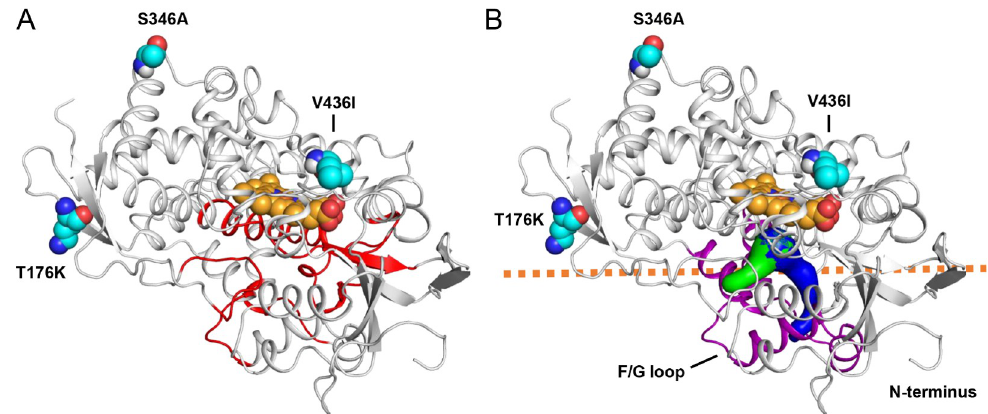
Fig 6. CYP6ER1vA model showing sequence variants (cyan) and heme (orange). (A) SRS1-6 regions are coloured red. (B) Access tunnels leading to the active site are shown in surface format. The predicted membrane-solution interface is depicted with orange dashes. The F/G loop is coloured